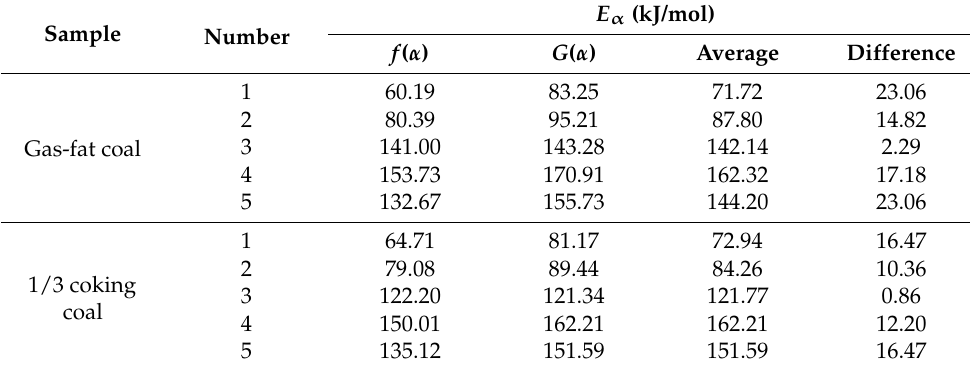
Figure 5. E a values of 1/3 coking coal and gas-fat coal calculation by the Achar differential and Coats- Redfern Integral method with five functions. Table 3. The E a value obtained by multi-model fitting using the Achar differential and Coats–Redfern integral